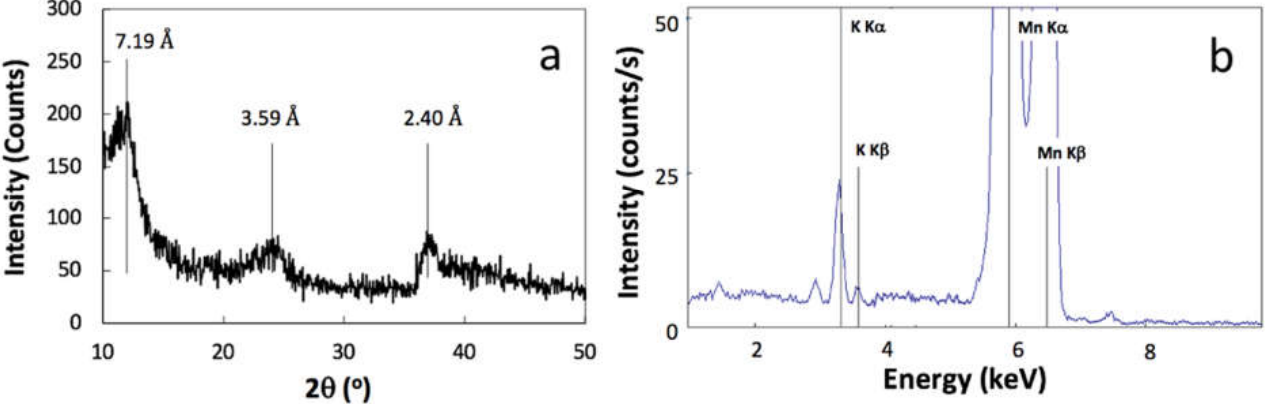
Figure 2. Solid phase analysis of synthetic MnO 2 showing the ( a ) X-ray diffraction (XRD) pattern and ( b ) X-ray fluorescence (XRF) spectrum.